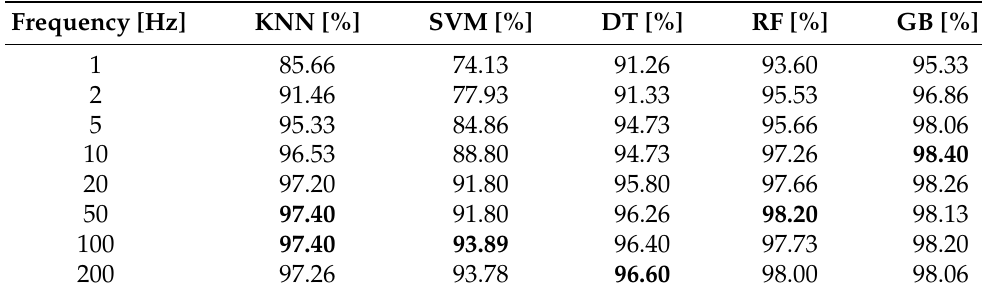
Table 5. Comparison of the Sensitivity across the ML algorithms, with the highest values in bold.